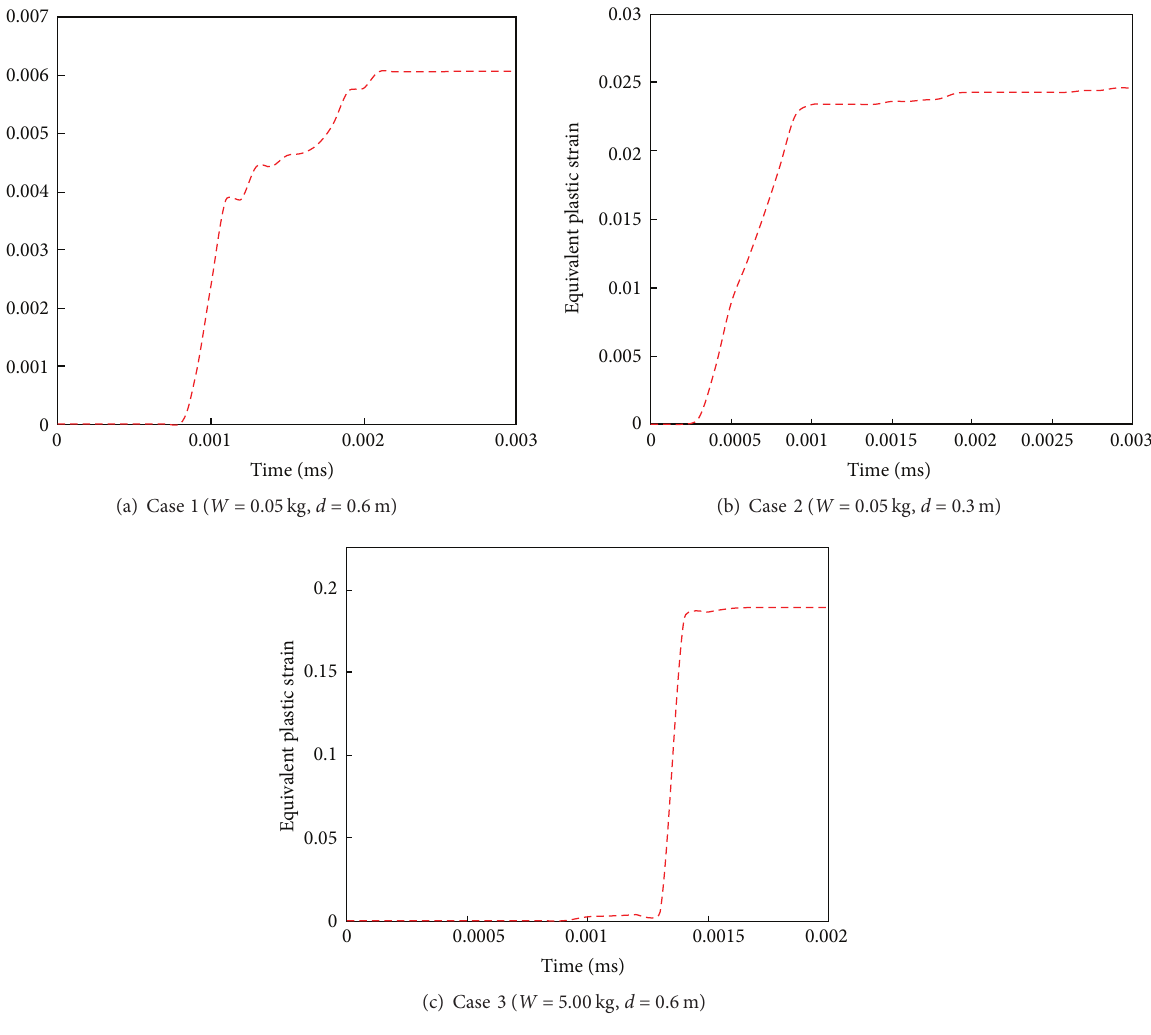
Figure 22: Plastic damage of three